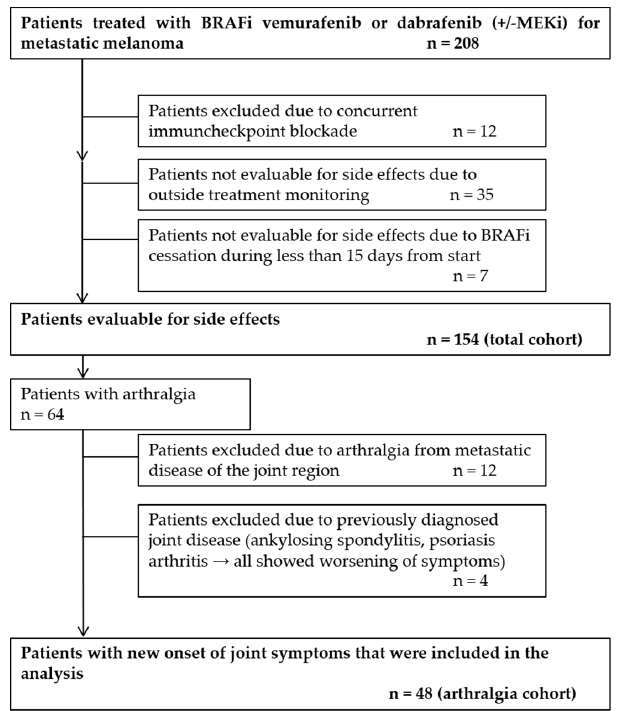
Figure 1. Flow diagram illustrating the process of patient selection. Cessation of BRAFi therapy in non-evaluable patients was due to unacceptable toxicity or performed at patient’s wish.